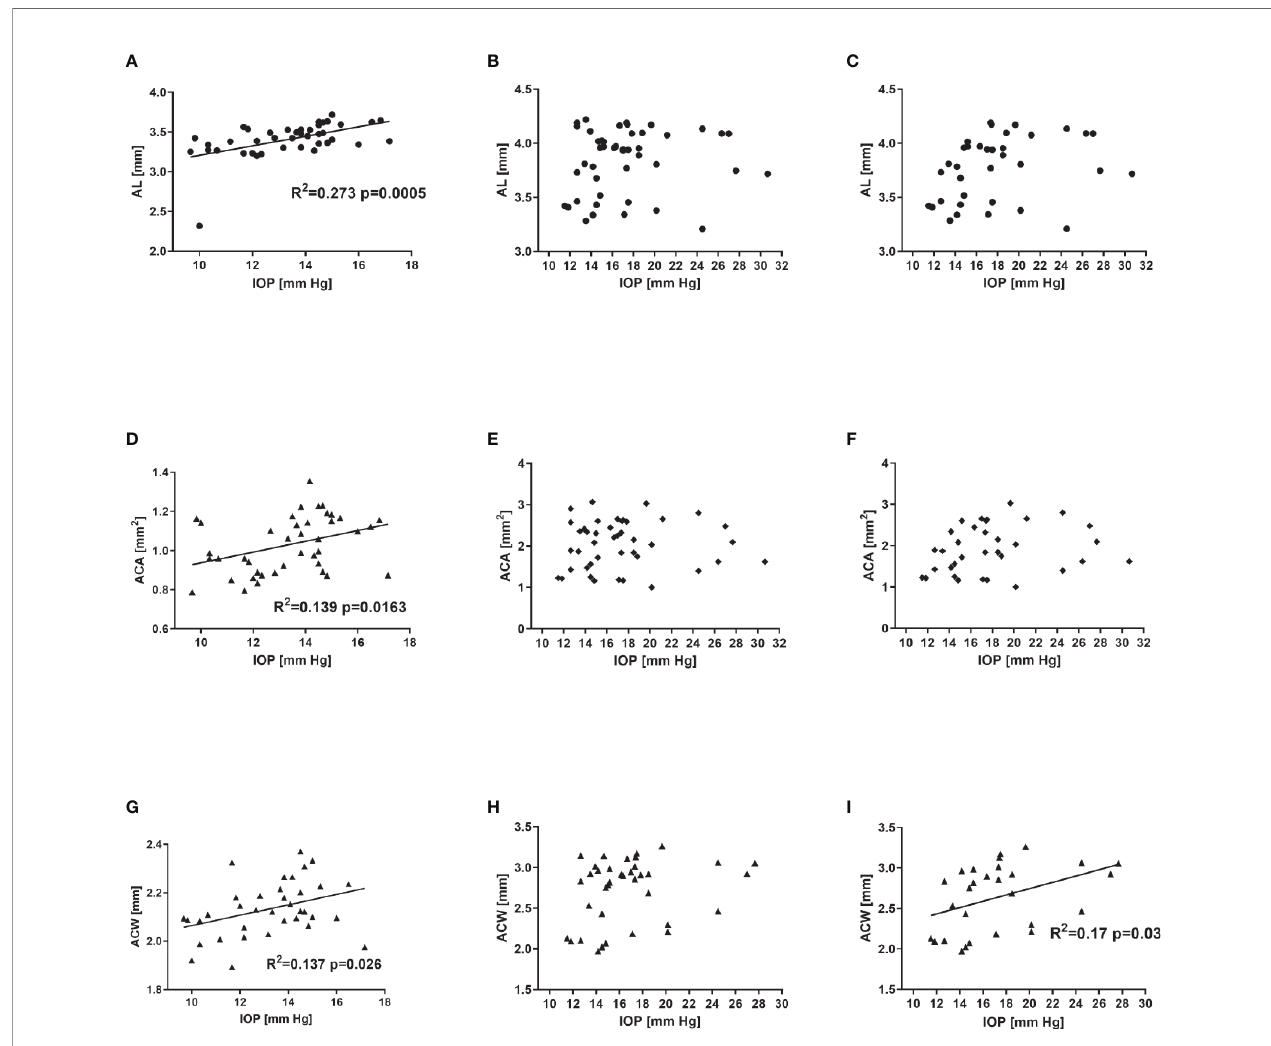
FIGURE 6 | Relationship between intraocular pressure and selected ocular dimensions in C57BL/6J ages 3 to 15 months ( fi rst column - A , D , G ), DBA/2J mice ages 3 to 15 months (second column – B , E , H ) or DBA/2J mice ages 3 to 12 months (third column C , F , I ). Graphs illustrate axial length (AL, A – C ), anterior chamber area (ACA, D – F ), and anterior chamber width (ACW, G – I ). Dots represent single values, lines represent linear correlations. Respective R 2 (if applicable) and P values are placed inside the